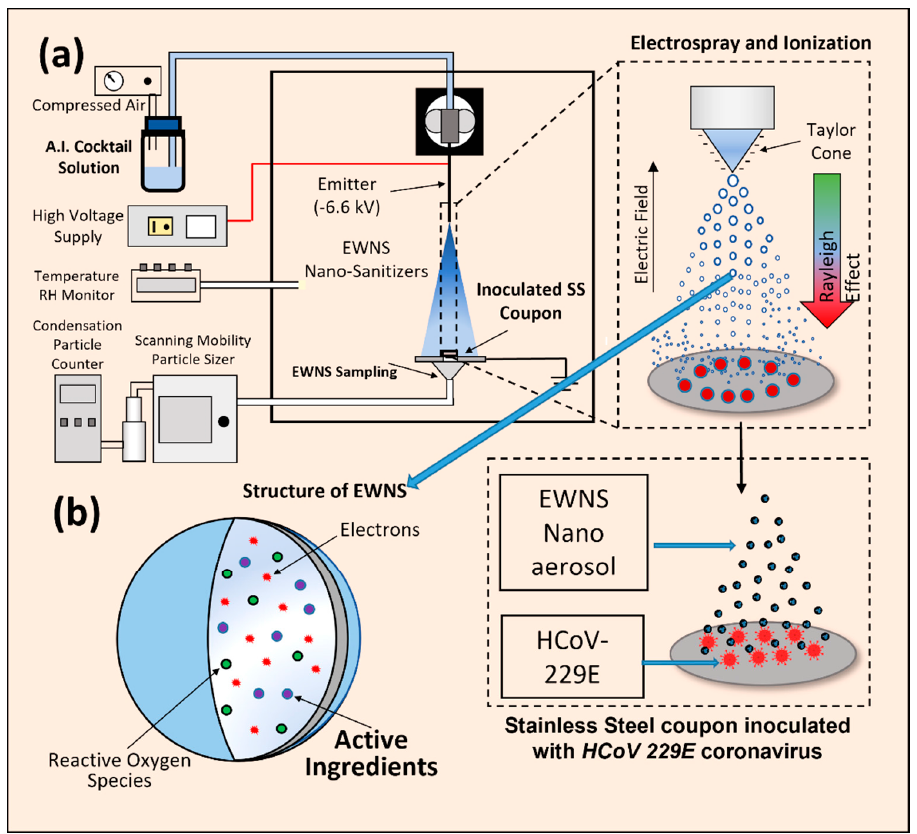
Figure 1. Detailed schematic to represent the generation of EWNS and the treatment of HCoV- 229E inoculated surface ( a ). The structure of an individual EWNS ( b ) containing the A.I., ROS and charges is also shown. is also